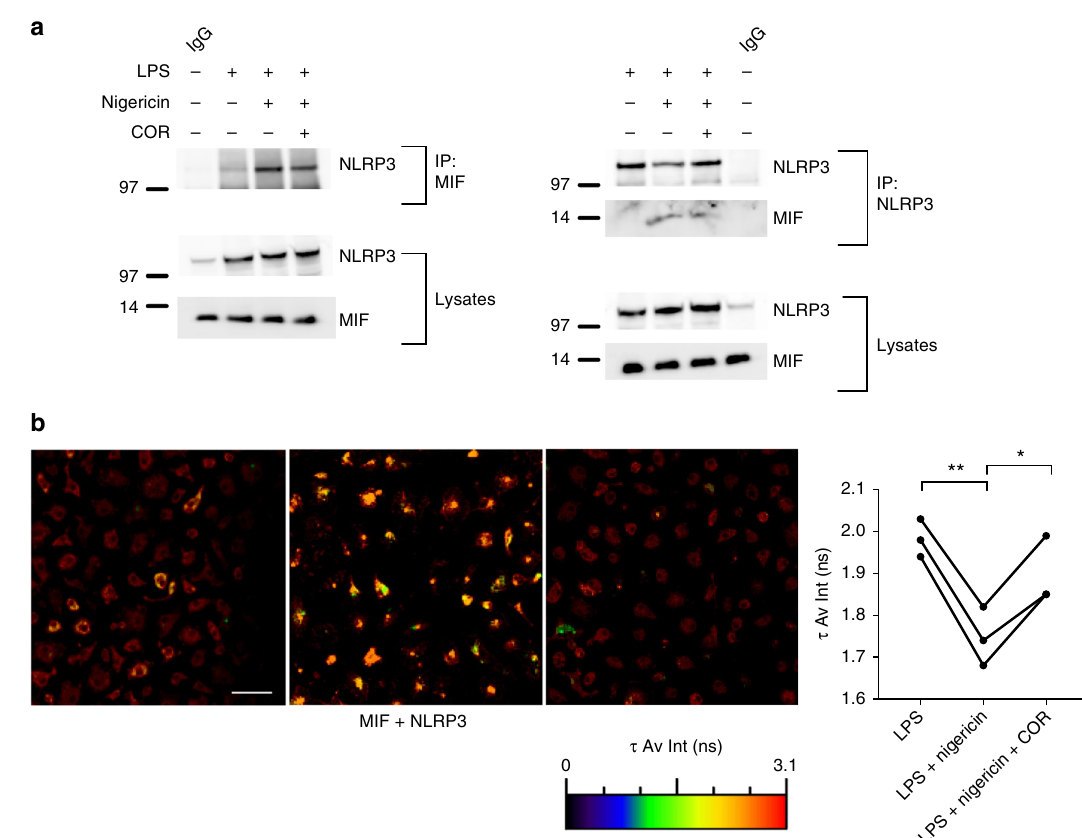
Fig. 8 MIF interacts with NLRP3. a Immortalized BMDMs were left untreated, primed with LPS alone (100 ng ml − 1 ) for 5 h, or primed with LPS before in fl ammasome activation with nigericin (5 µ M, 30 min). Lysates were immunoprecipitated with anti-MIF or anti-NLRP3 antibody, followed by western blot analysis with antibodies against NLRP3 and MIF. b WT BMDMs were primed with LPS alone (10 ng ml − 1 ) for 5 h, primed with LPS followed by NLRP3 activation with nigericin (5 µ M) for 30 min, or primed with LPS followed by COR123625 (50 µ M) treatment for 2 h prior to the addition of nigericin (5 µ M) for 30 min. Levels of interaction between MIF and NLRP3 were assessed by FLIM-FRET microscopy. FLIM-FRET images presented are representative of three independent experiments. Scale bar = 50 μ m. Graphs show changes in the amplitude-weighted average lifetime ( τ Av Amp) of the donor (A488) due to proximity to the acceptor (A568). Combined data from three mice, analyzed by paired t test. * P < 0.05, ** P <